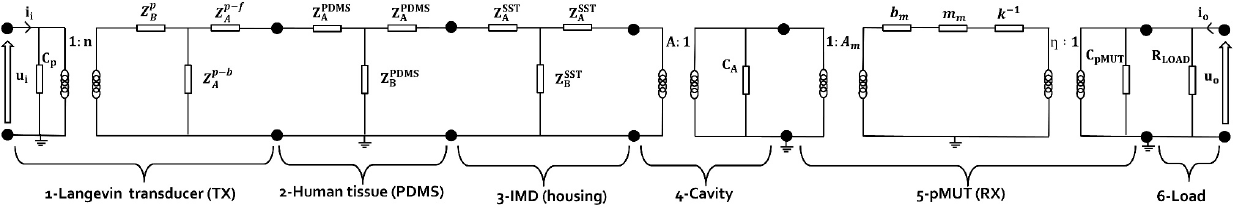
Figure 6. Entire lumped parameter transmission line model used to simulate the UPD system.